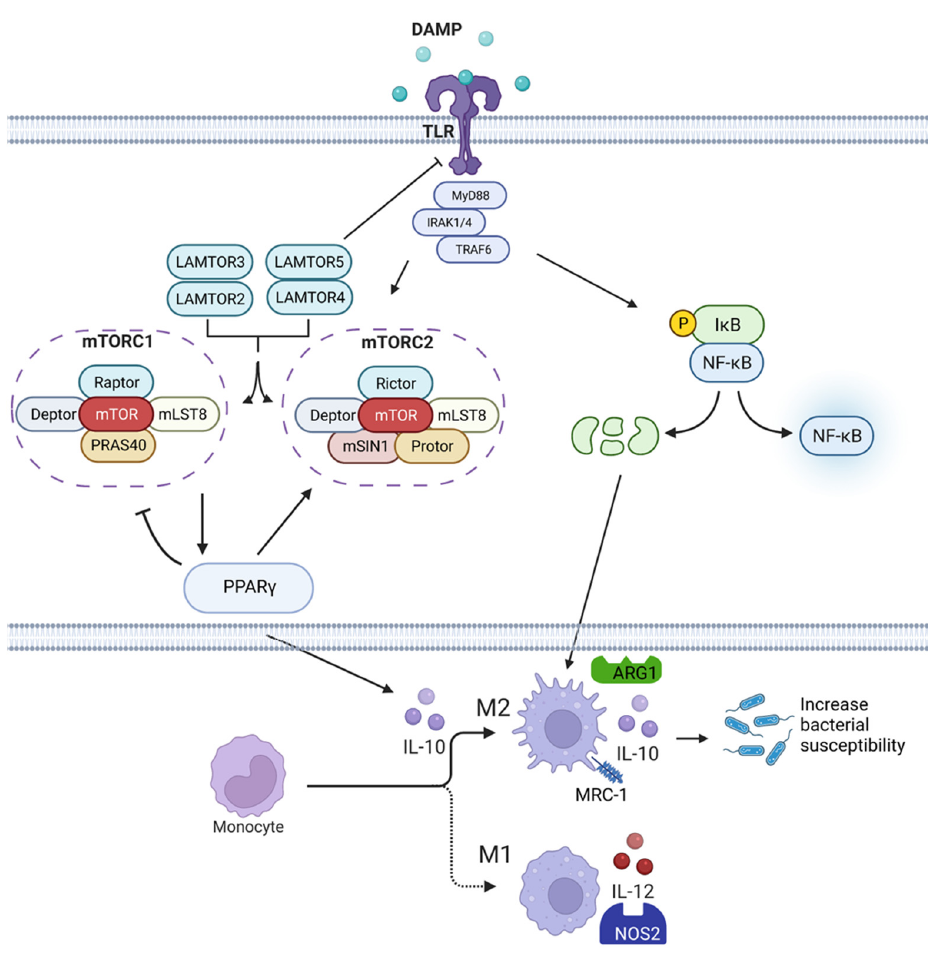
Figure 8. Release of damage-associated molecular patterns (DAMPs), and activation of mTOR/PPAR γ and NFkB axes drive mixed antagonist response syndrome (MARS) immune dys- function after burn and inhalation injuries (created by BioRender). Proposed molecular model of the acute burn injury-induced imbalance within the mTOR/PPAR γ and NF κ B/I κ B immunoregulatory axes early after an injury that induces and regulates the acute shock → chronic clinical susceptibility to infection.